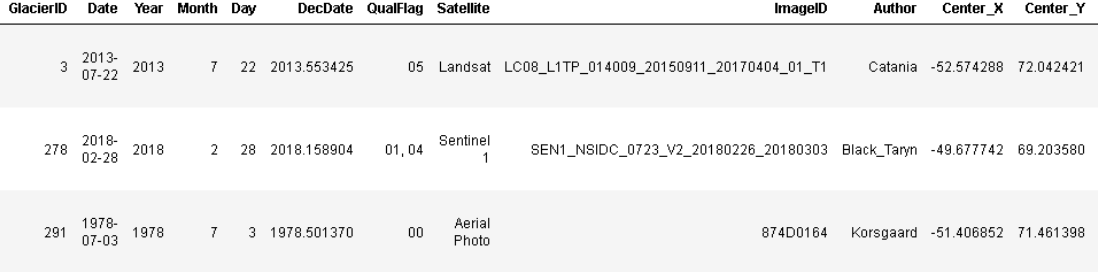
Figure 3. Example metadata for the TermPicks data set. Each column corresponds to the description in Sect. 2.4 (“Metadata